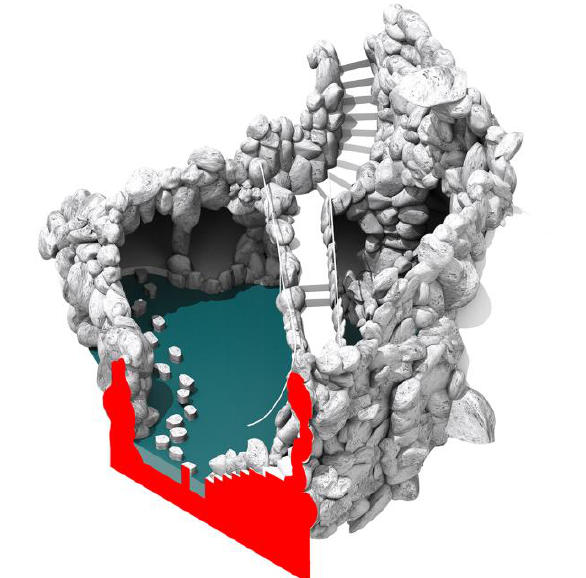
Figure 6 . The Quinta da Regaleira in Sintra, the Lago da Cascata , sectioned digital model.